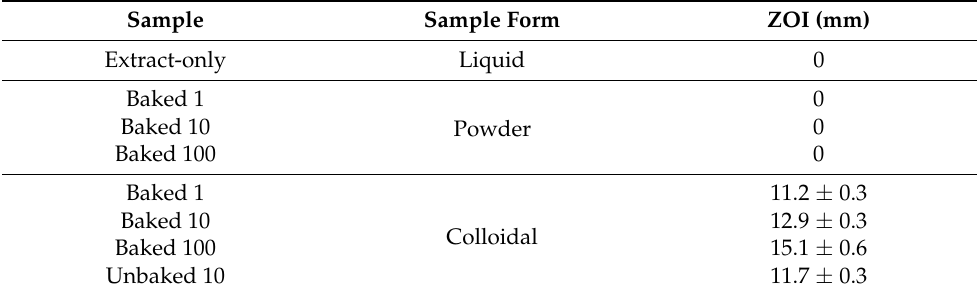
Table 2. Antibacterial results of samples from disc diffusion method .